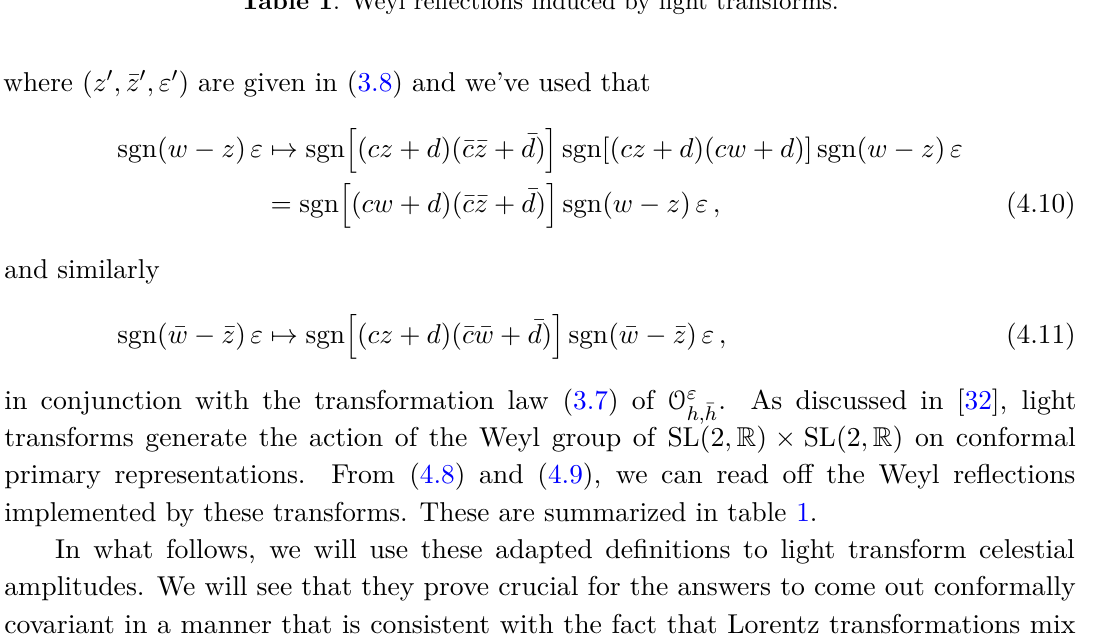
Table 1 . Weyl reflections induced by light